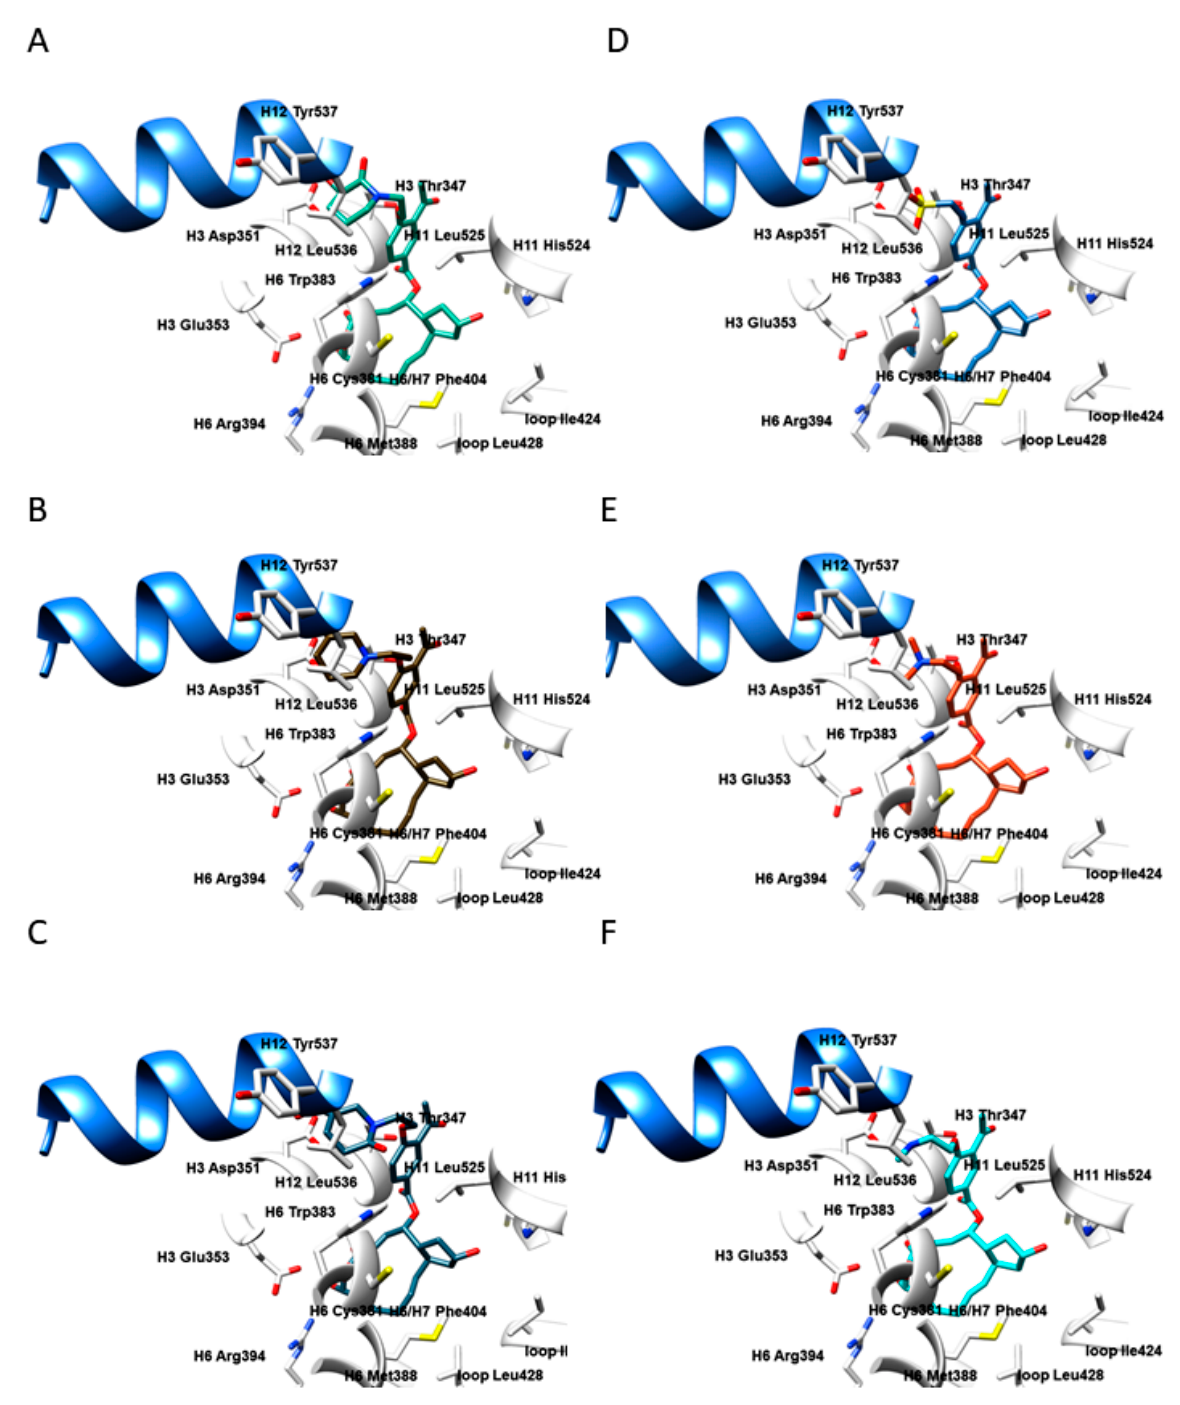
Figure 7. The bioactive conformations of 3DPQ-12 ( A ); 3DPQ-3 ( B ); 3DPQ-9 ( C ); 3DPQ-4 ( D ); 3DPQ-2 ( E ); 3DPQ-1 ( F ) within the ER α active site. Amino acid residues are depicted in white, H12 helix is presented in cornflower blue ribbon. presented in cornflower blue